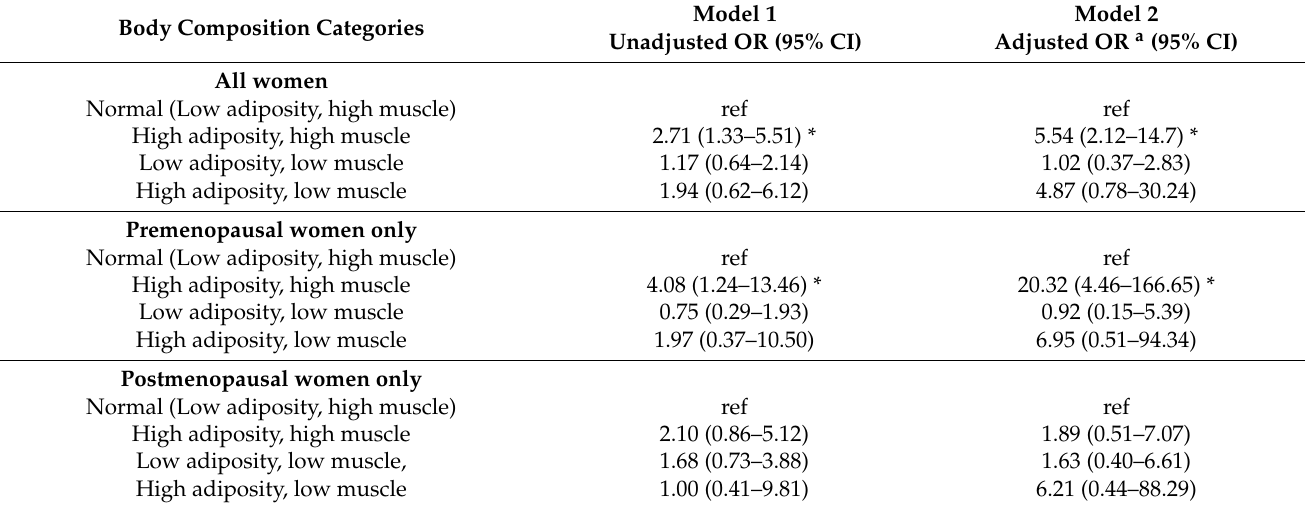
Table 5. Four-category of body composition phenotype in relation to TNBC